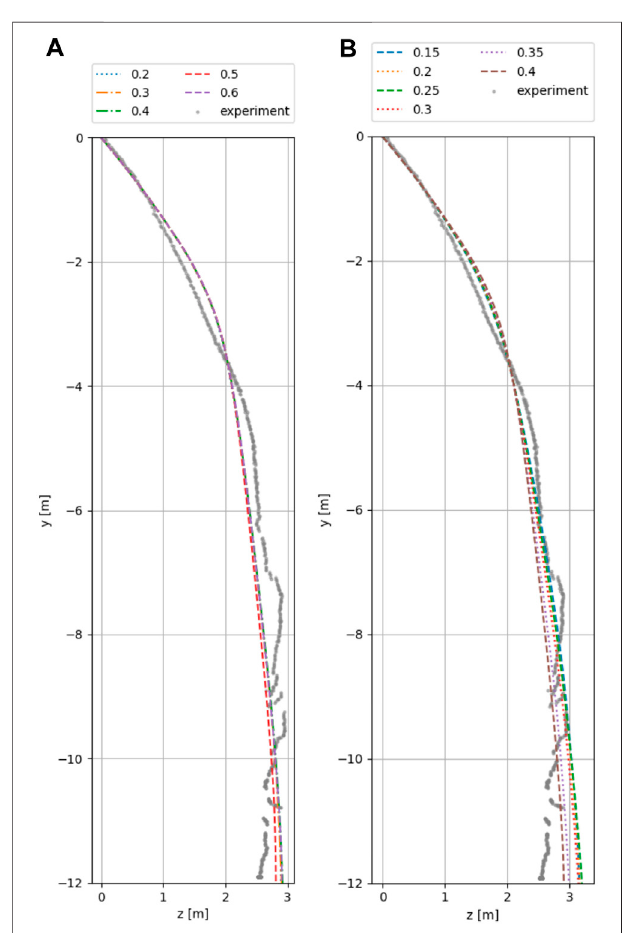
FIGURE 10 | Visualization of object path for varying parameters for T092. (A) Coef fi cient of restitution. The result data for 0 . 2 , 0 . 3 , 0 . 4 , and 0.6 are nearly identical and thus hardly distinguishable in the graph. (B)